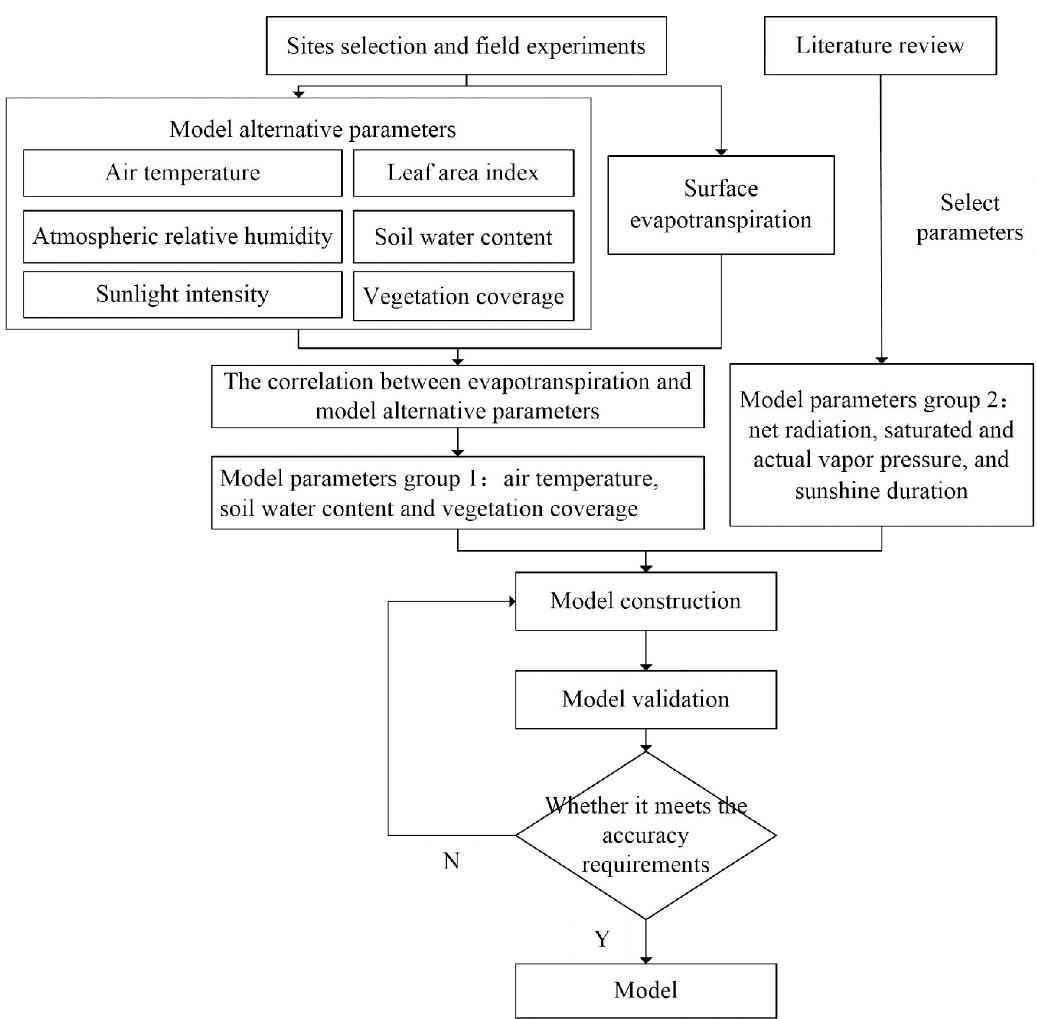
Fig 2. Flow chart of modeling